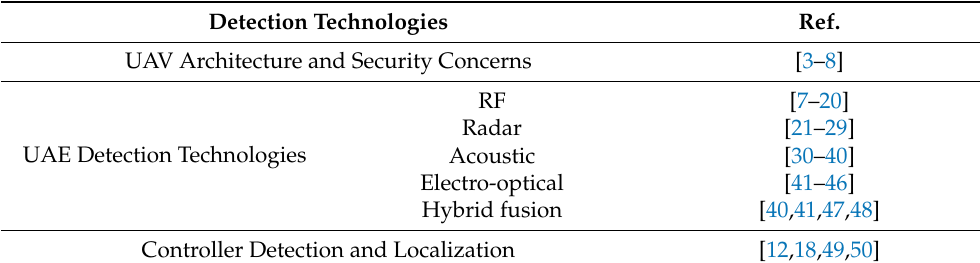
Table 1. Summary of reviewed topics for drones and their controller detection. Detection